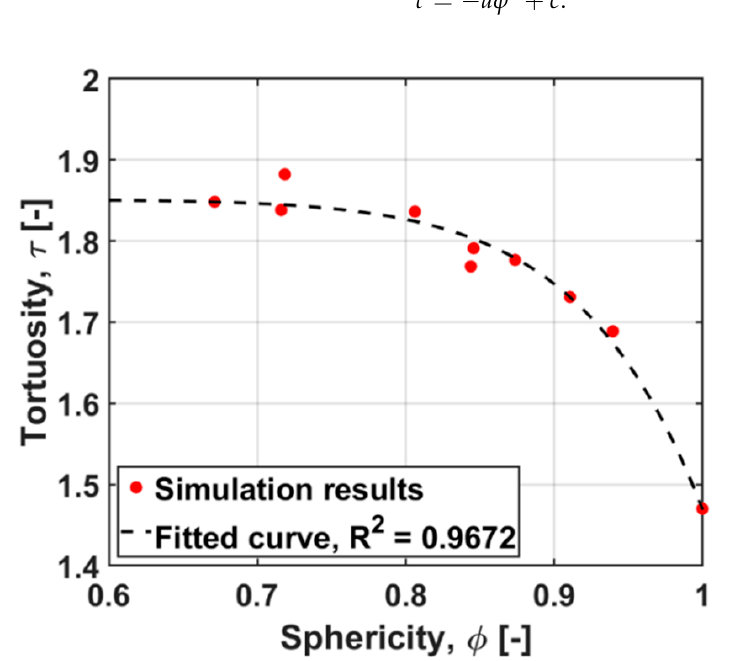
Figure 8. Comparison of bed tortuosity as a sphericity function; dotted line represents the correla-